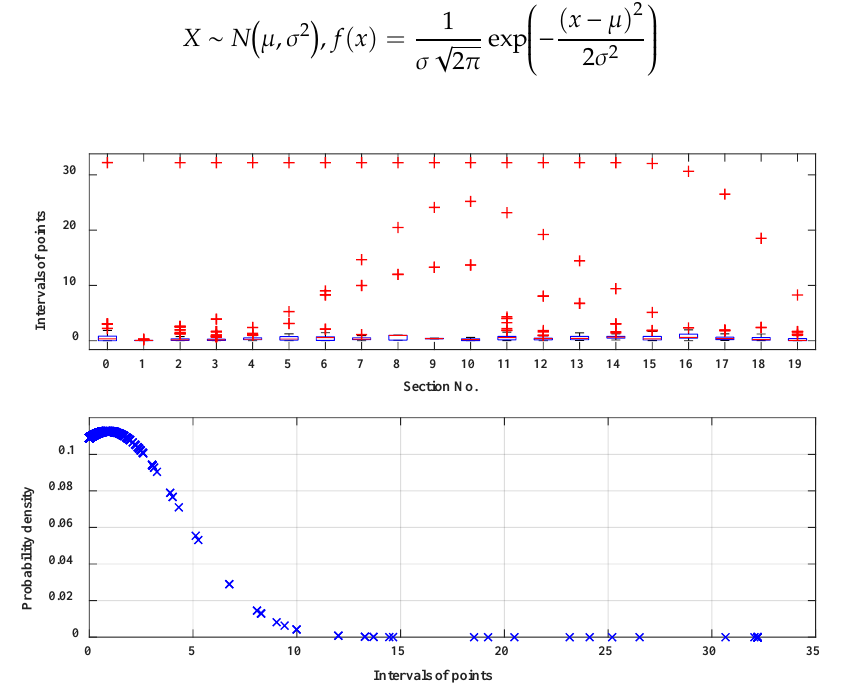
Figure 5. Intervals of points on sections (KCS; 20 slices).